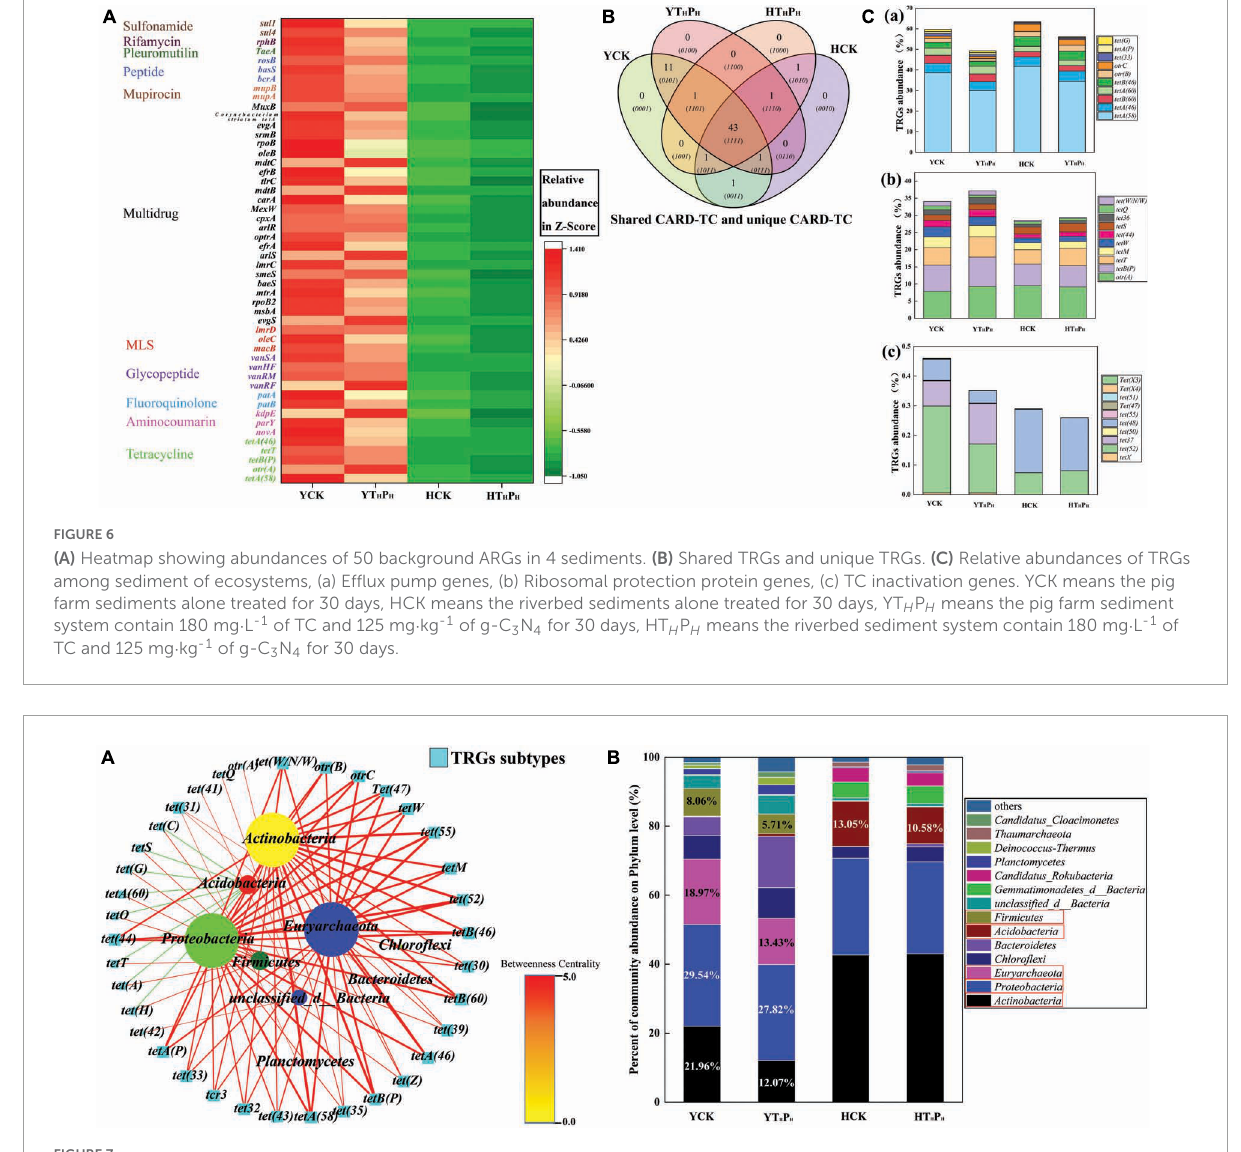
Zheng et al., 2021). Photogenerated holes (h + ) and